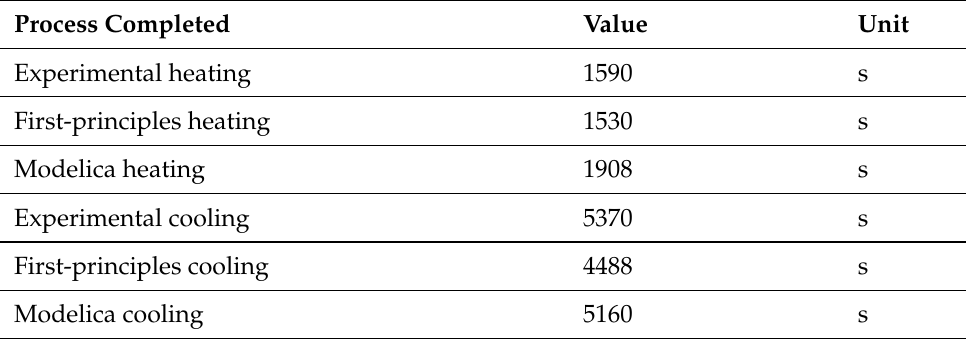
Table 10. Times to Complete Heating and Cooling